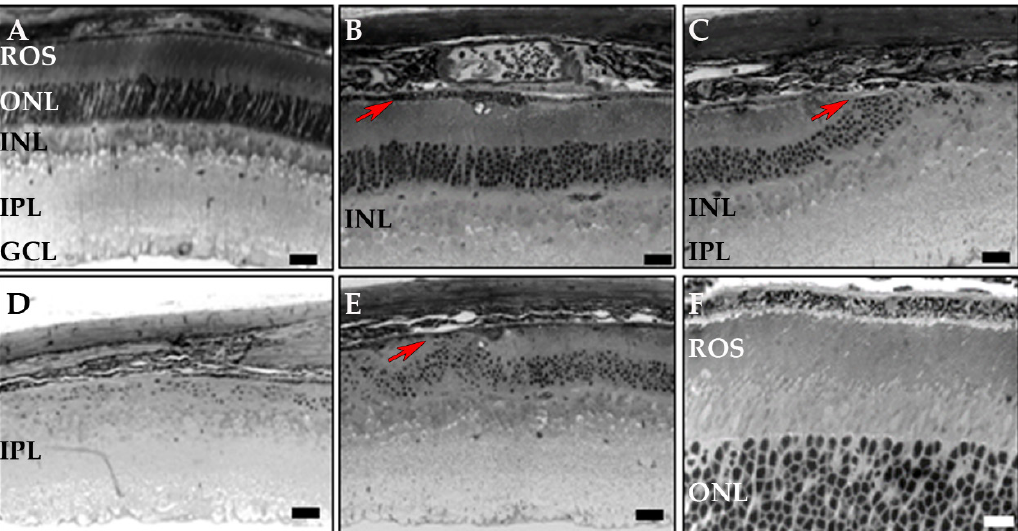
Histologically, at PN 3 months, light micrograph images revealed that all retina layers in mice